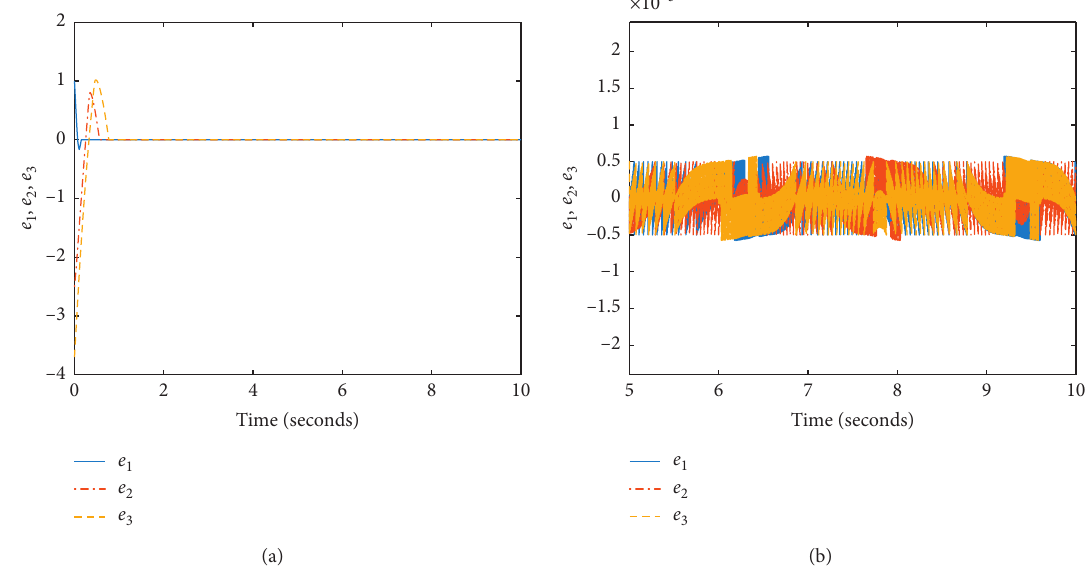
Figure 1: The trajectories of tracking errors e